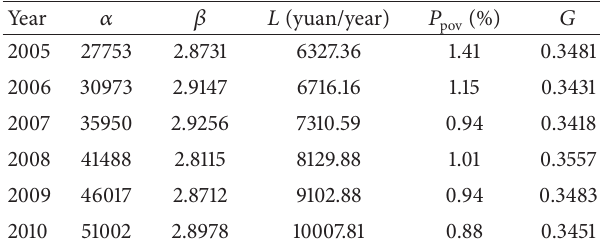
Table 6: Gini coefficient and poverty ratio of urban residents from 2005 to